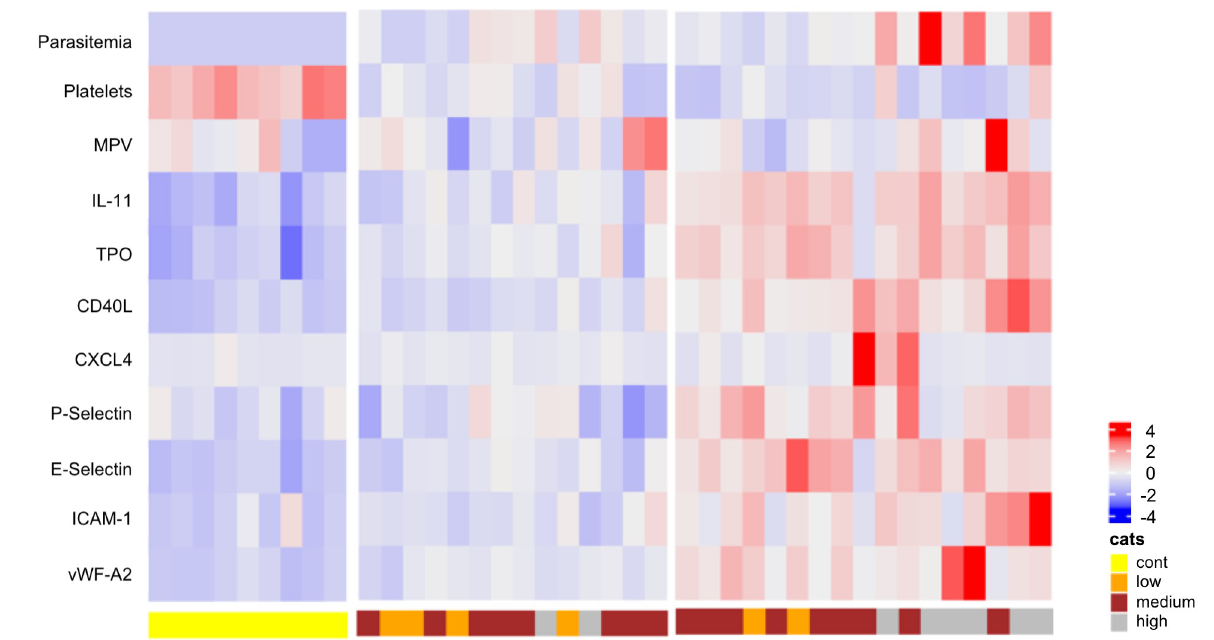
Fig 4. Heatmap of analyte expression. The heatmap represents z-scores obtained by centering variables (parasitemia, platelet parameters and markers of endothelial cell activation) with the Scale() Function in R, followed by hierarchical and k-means clustering analysis, showing three distinct clusters of controls and two groups of patients. Yellow: Controls; Orange: low parasitemia; Brown: moderate parasitemia; Gray: high parasitemia.